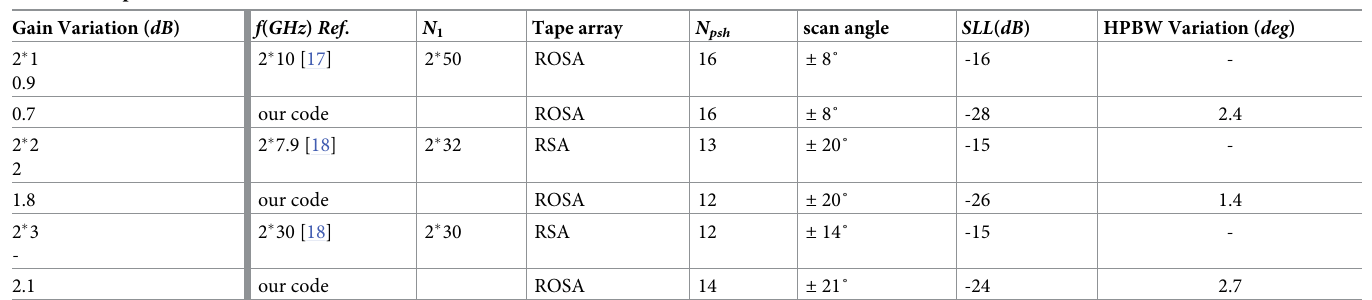
Table 2. Comparison of the results of our code in with references for some cases. Gain Variation ( dB ) f ( GHz ) Ref .